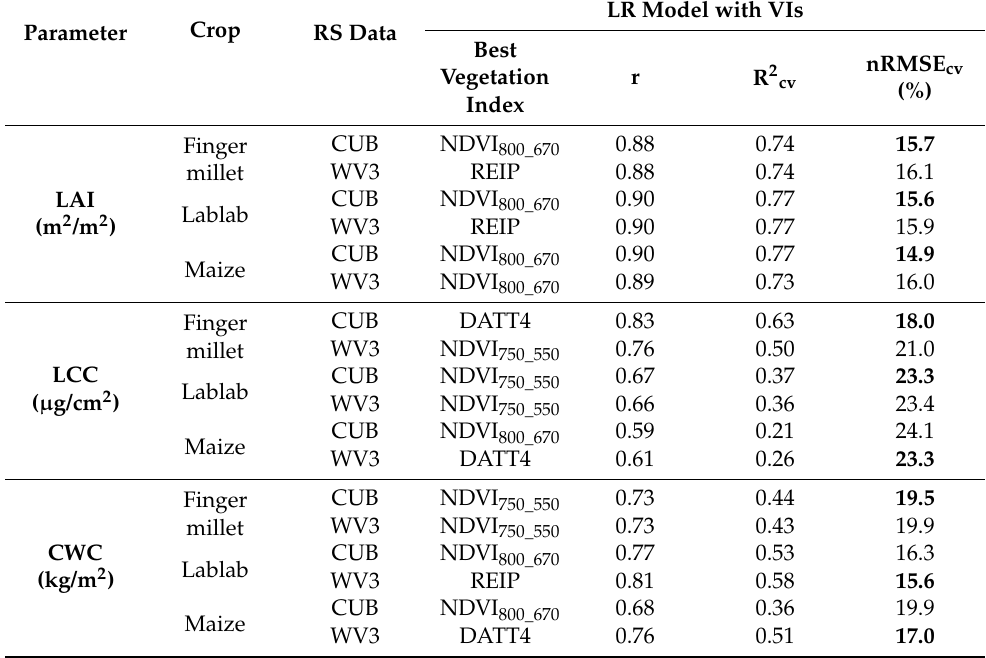
Table 4. Summary of the crop parameter estimation model results from linear regression (LR) using the best-correlated vegetation index (VI). Bold values indicate the lowest nRMSEcv values among the two remote sensing datasets for each crop type. All the reported linear regression models with the best vegetation index showed p -value less than 0.05. (LAI: leaf area index, LCC: leaf chlorophyll